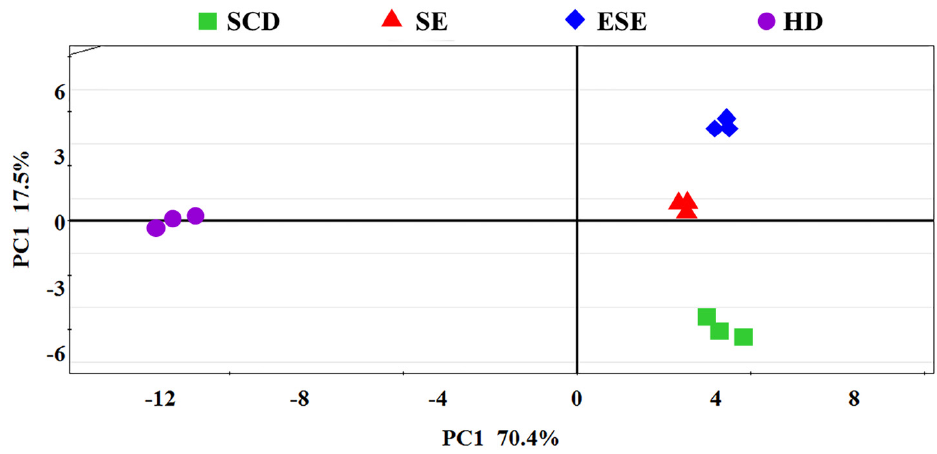
Figure 7. The PCA diagram of GC − MS of the SAEOs extracted by the four different methods.